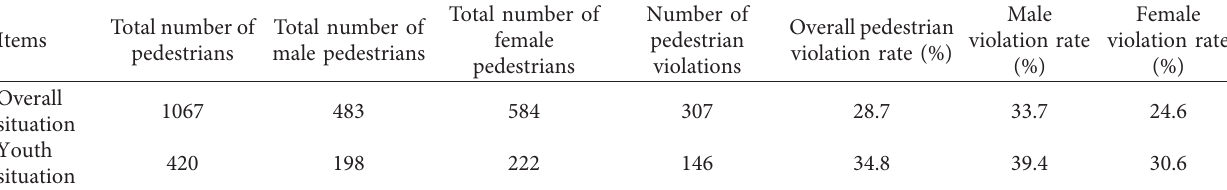
Table 2: Pedestrian data obtained from on-site survey at intersections.